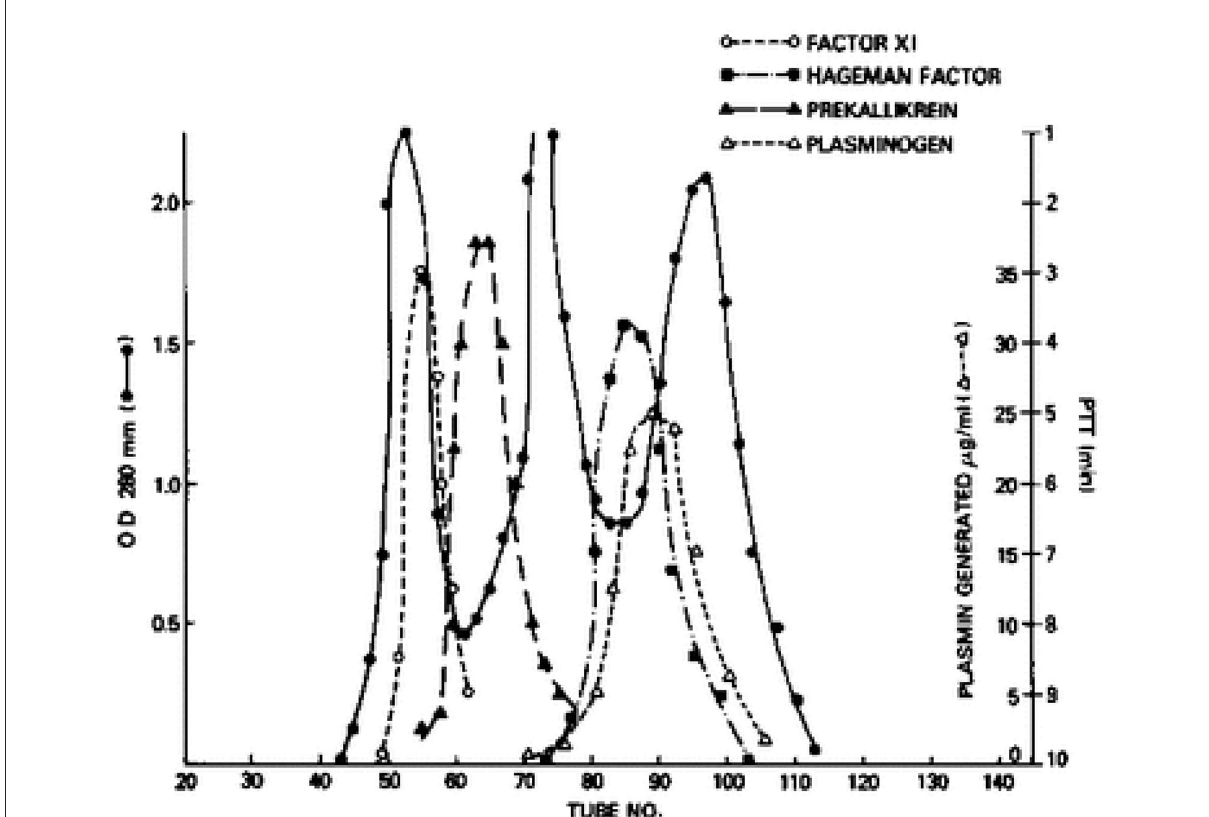
FIGURE2 Gel filtration of human plasma on Sephadex G-200. The OD 280 indicates 3 protein peaks. The location of factor XI, prekallikrein, factor XII (Hageman factor) and plasminogen was identified immunologically. The molecular sizes of factor XI and prekallikrein reflect the binding of each to